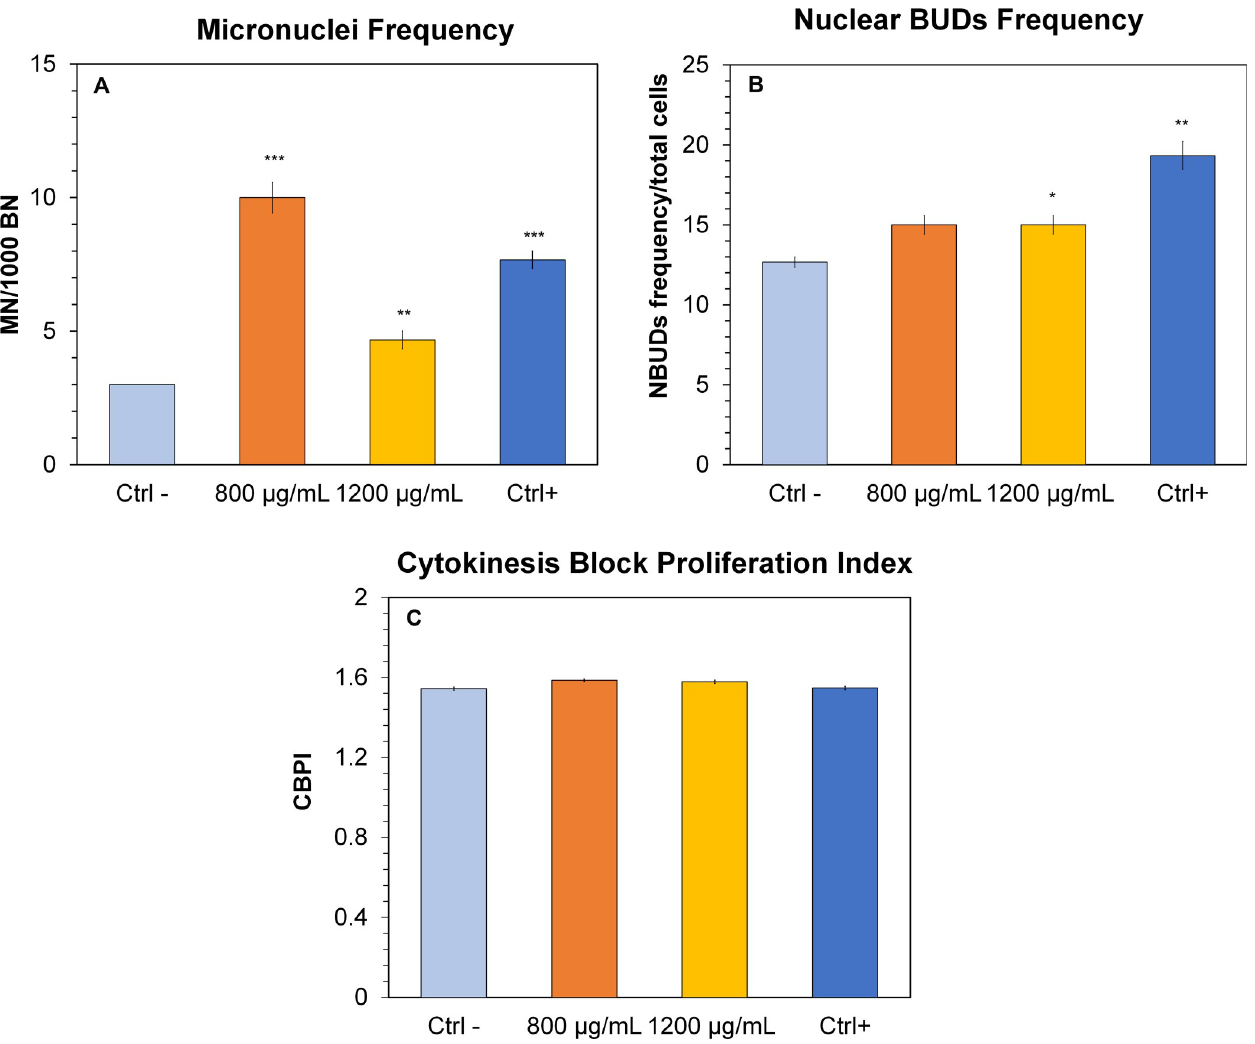
Fig 6. Micronuclei (BMN), Nuclear Bud (NBUDs) and Cytokinesis Block Proliferation Index (CBPI) in the HCT116 cells treated with polystyrene nanoparticles (PNPs). ( a ) Micronuclei: the number of MN refers to 1000 binucleated cells, ( b ) Nuclear Buds: refers to a total of 1000 binucleated cells and ( c ) CPBI, were evaluated at 800, 1200 μ g / mL after 48h exposure to PNPs. CBPI = ((N˚ mononucleated cells) + (2 x N˚ binucleated cells) + (3 x N˚ multinucleated cells))/ (total cell number). Colchicine was used as a positive control. Significance values � = p < 0.05; �� = p < 0.005; ��� p = 0.0005; error bars represent the standard error of the